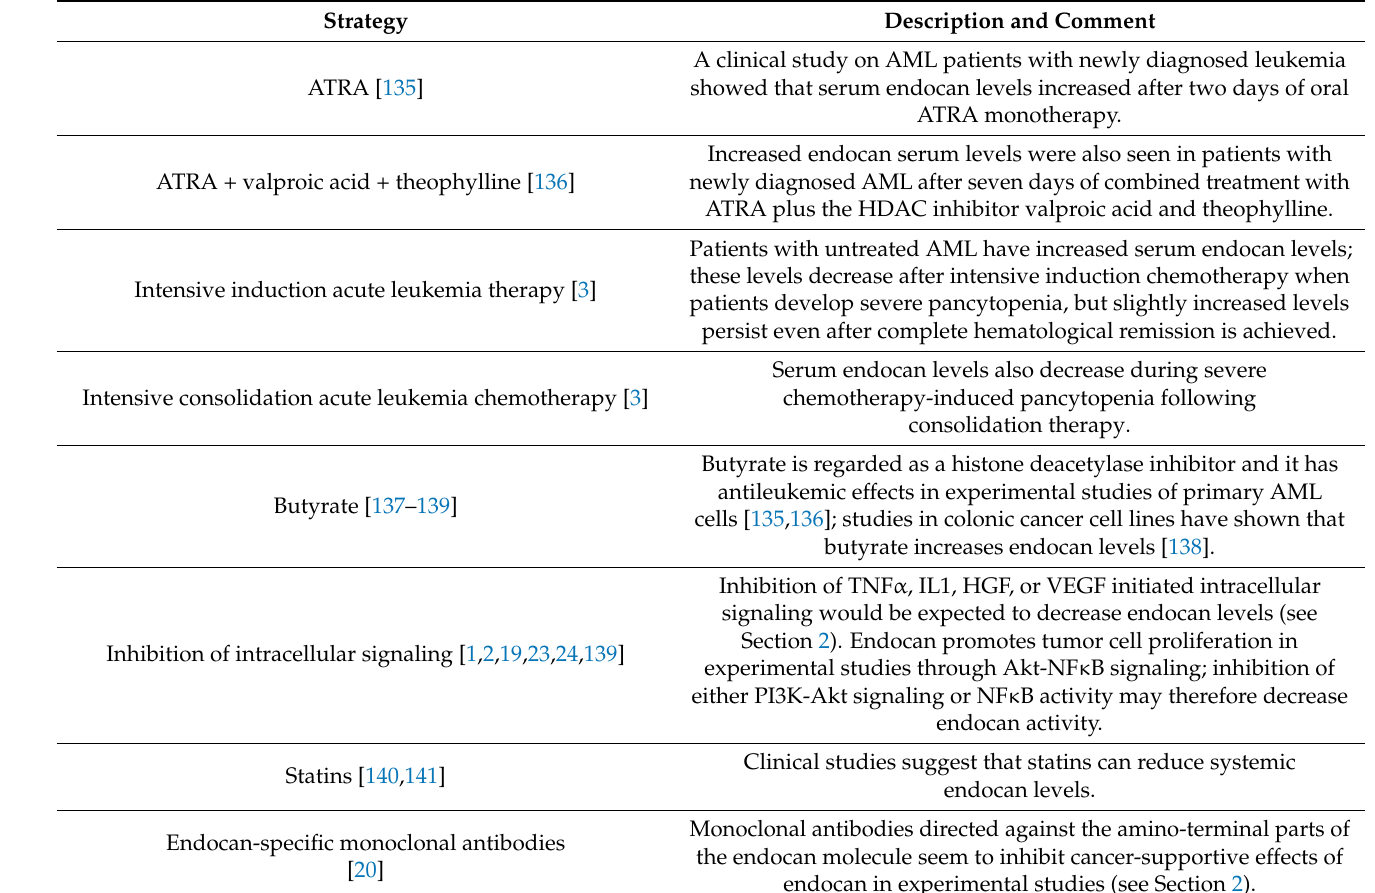
Table 1. Possible pharmacological strategies for targeting endocan and modulation of